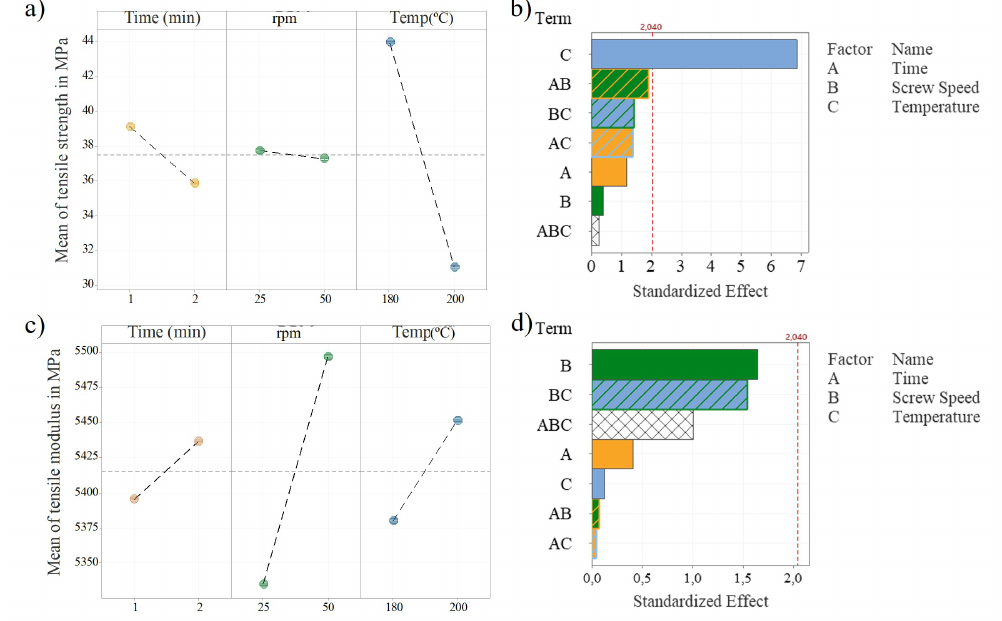
Figure 4. Main effect plots for the response of ( a ) tensile strength and ( c ) tensile modulus and Pareto charts of standardised effects for ( b ) tensile strength and ( d ) tensile modulus.